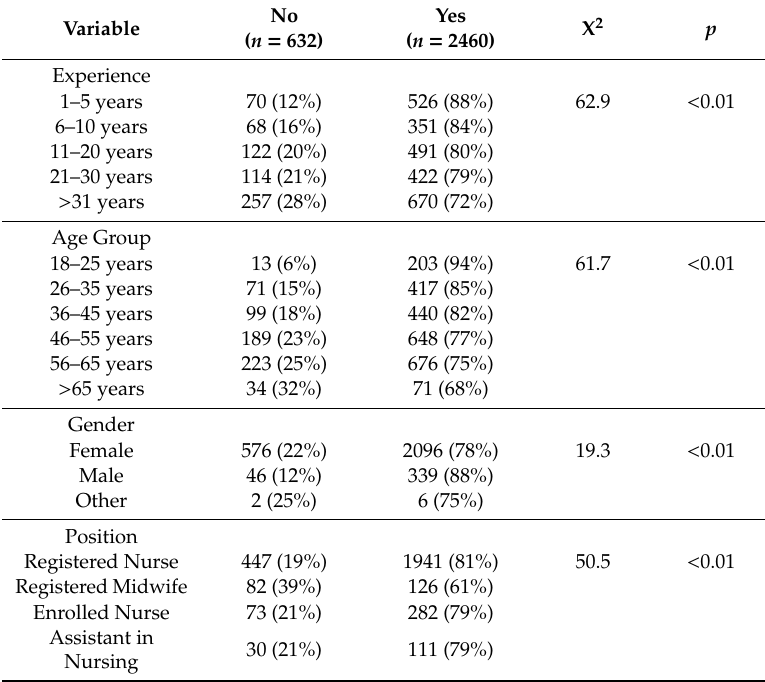
Table 4. Episodes of violence and participant